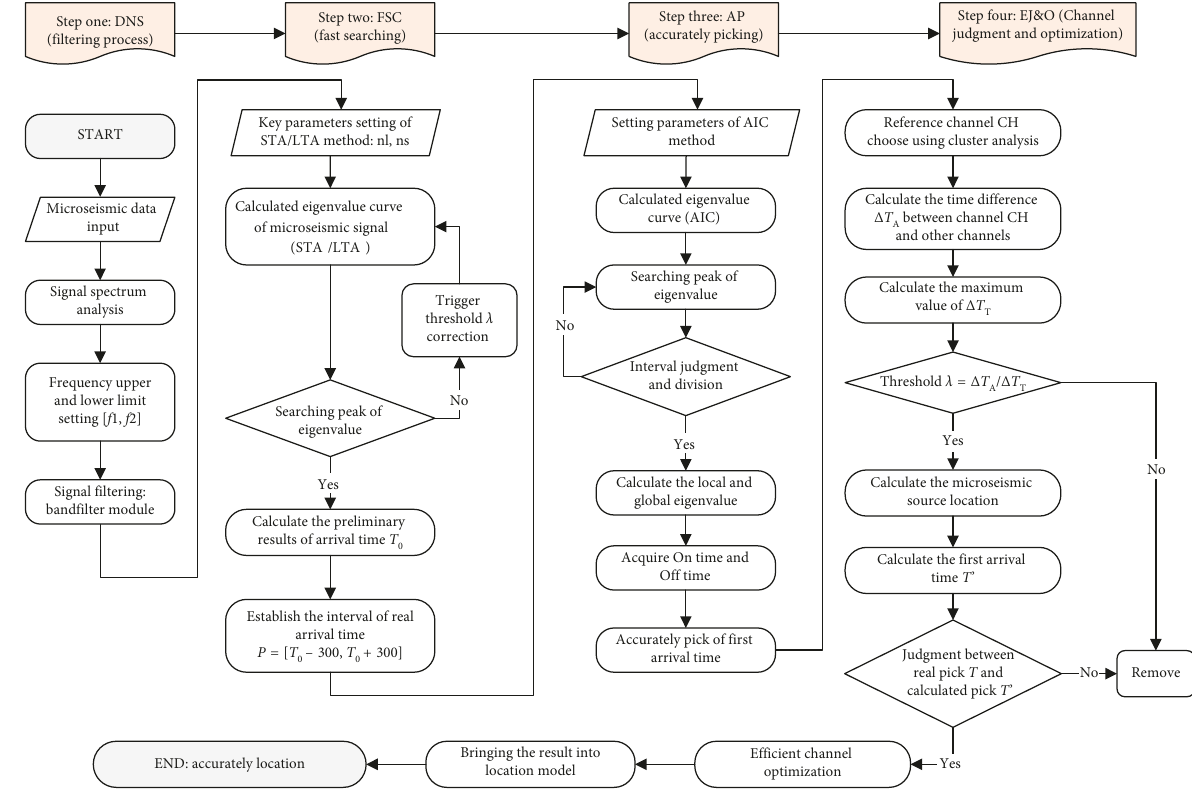
Figure 2: Flow chart of arrival time picking and effective